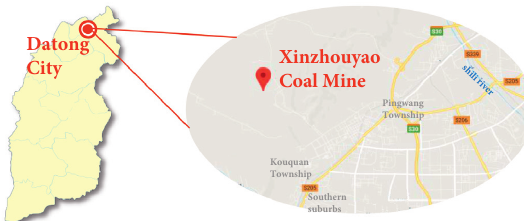
Figure. 1: Location of Xinzhouyao coal mine, Datong City, Shanxi Province,